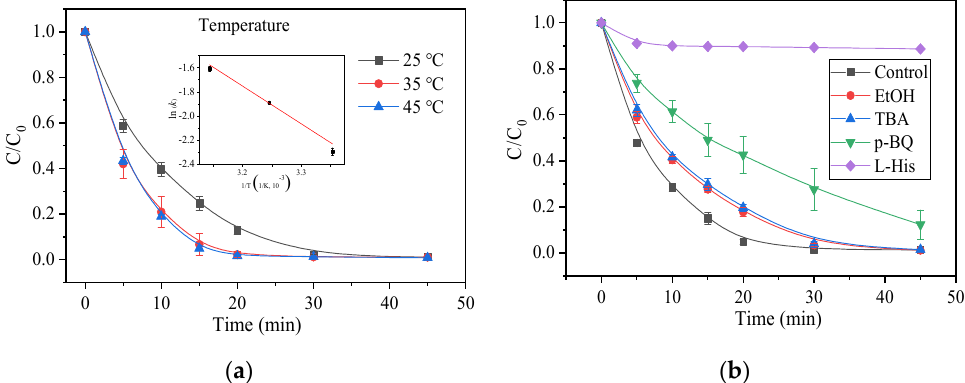
Figure 4. ( a ) Influences of reaction temperature; ( b ) influences of different quenchers on PMS oxidation for AO7 degradation. Condition: [AO7] = 50 mg/L, [catalyst] = 100 mg/L, [PMS] = 614 mg/L = 2 mM, T = 25 °C, [TBA] = [EtOH] = 0.5 M and [p-BQ] = [L-his] = 10 mM.